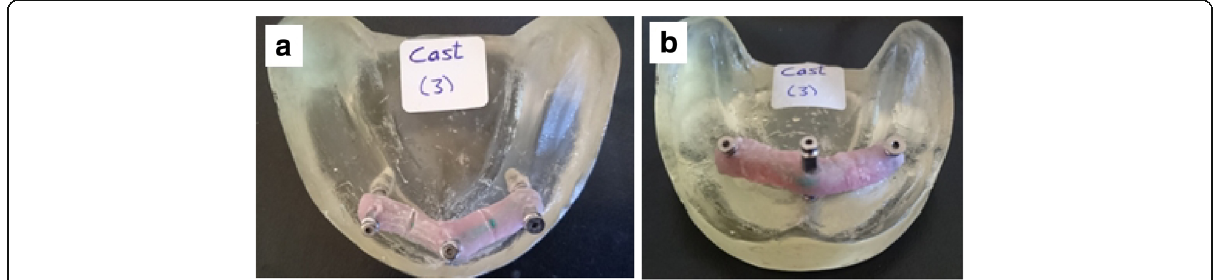
Fig. 3 a The splint sectioned into three separate pieces. b Resplinting with acrylic